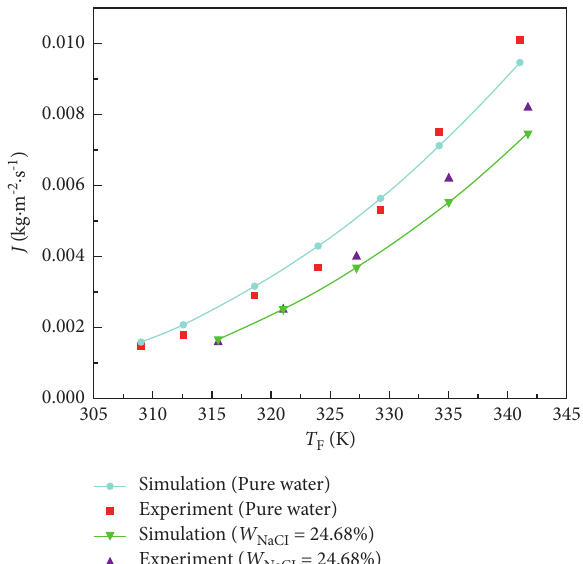
Figure 4: Comparison of permeate mass flux between the simulating results with experimental data. Pure water: V P F � P P � P 0 , T P � 292.7K, W NaCl � 0; NaCl solution: V F � V P � 0.145m/s, P F � P P � P 0, T P � 293.5K, W NaCl �